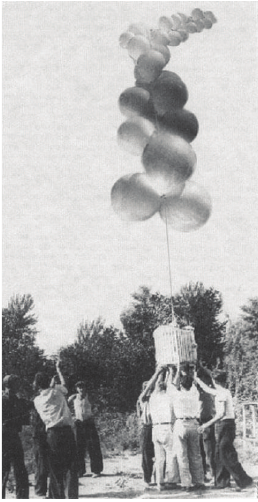
Figure 1: The moment of launch of the instrument for cosmic ray research on the garland of balloons.